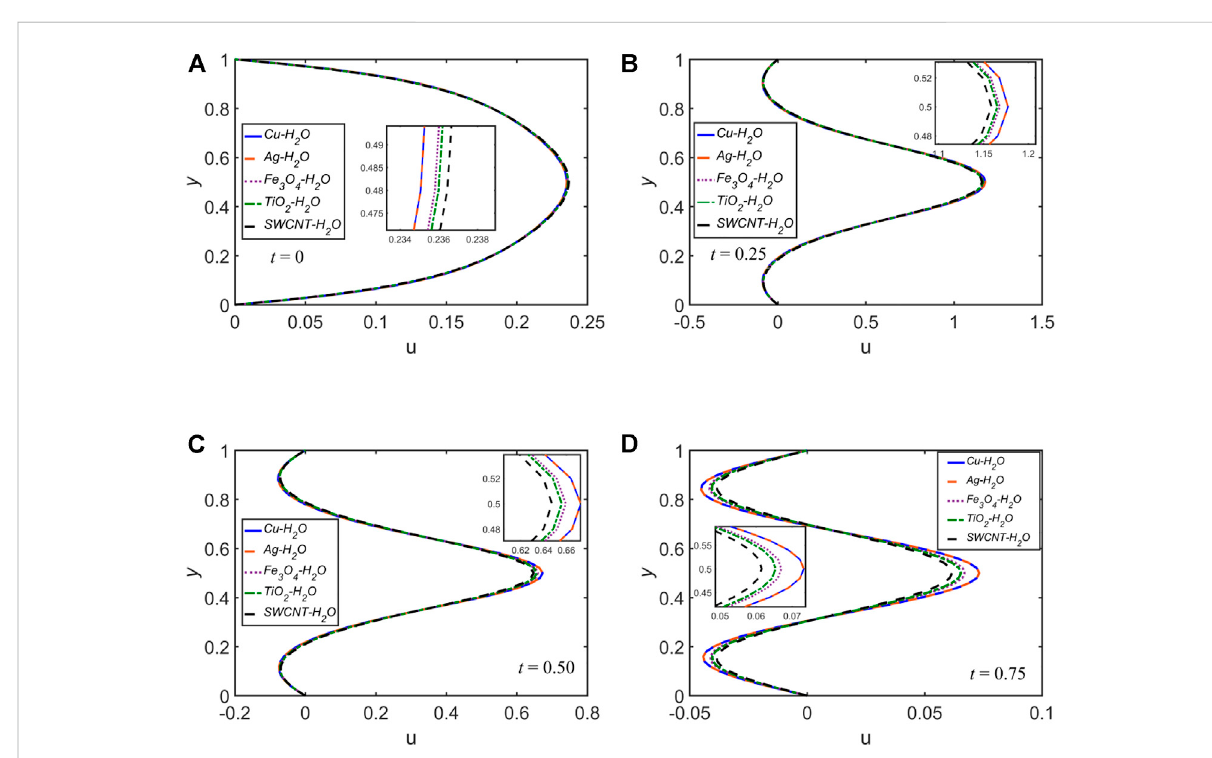
The velocity pro fi le u versus y at x (cid:2) 2 for the fi ve NFs at the four time